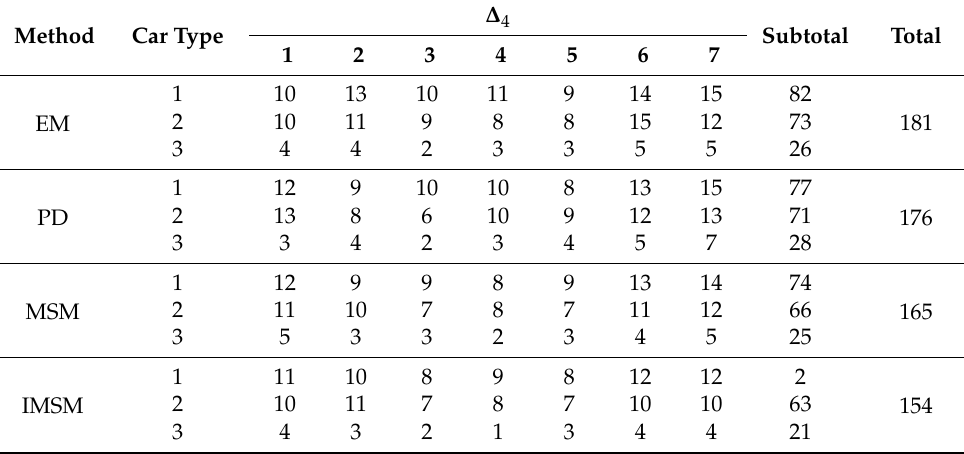
Table 11. Hybrid forecasting results based on different estimation methods.